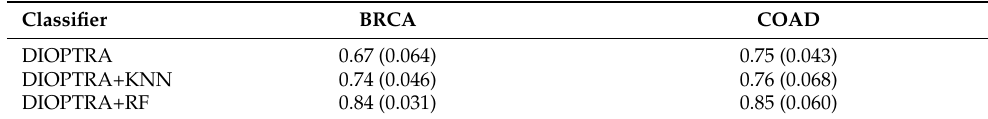
Table 2. Prediction accuracy achieved by DIOPTRA and DIOPTRA + Machine Learning Classifiers.